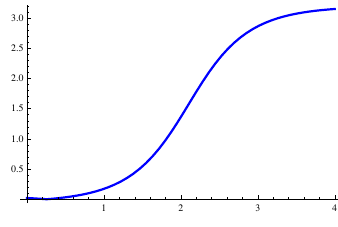
Figure 3. Similar synchronization loss in the case A = 1 , 0 . 1 = ω 1 (cid:54) = ω 2 = 0 . Graphics of the measure D ( t ) of the synchronization. Initial data θ (0) = 0 . 03 , φ (0) = 0 . 02.